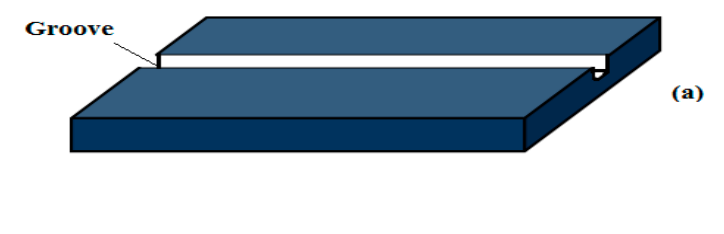
Figure 1. FSP tool: ( a ) compacting and FSP tool shape feature; ( b ) dimensional feature of FSP tool; ( c ) fabricated FSP tool.